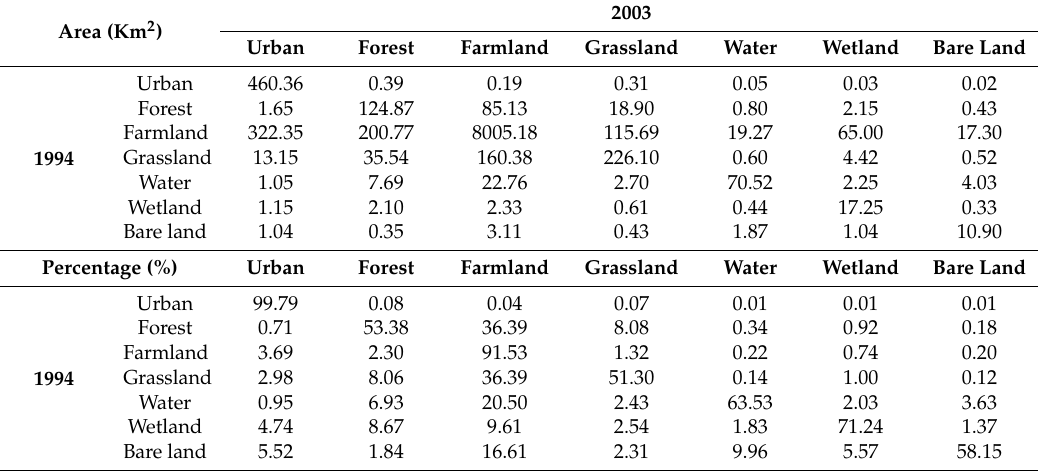
Table 3. Transition matrix of LULC area (km 2 ) and percentage (%) between 1994 and 2003. Area (Km 2 )